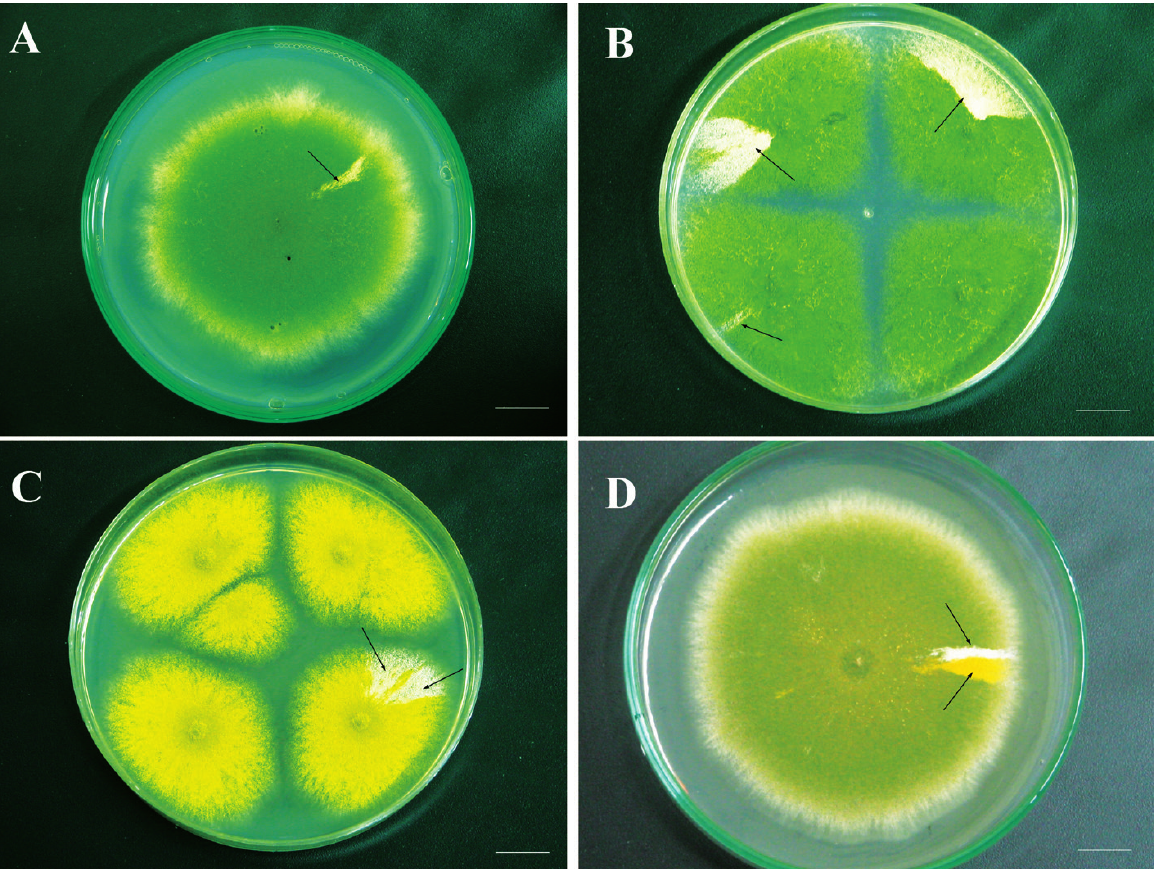
Figure 1 - Growth of A757//UT448 diploid strain in the absence of CPT or CPT-11 (control) (A) . Diploids obtained after treatment with CPT (17.4 µg/mL) (B-C) and CPT-11 (18 µg/mL) (D) . Arrows indicate the origin of mitotic segregants by the haploidization process. Bar = 5.0